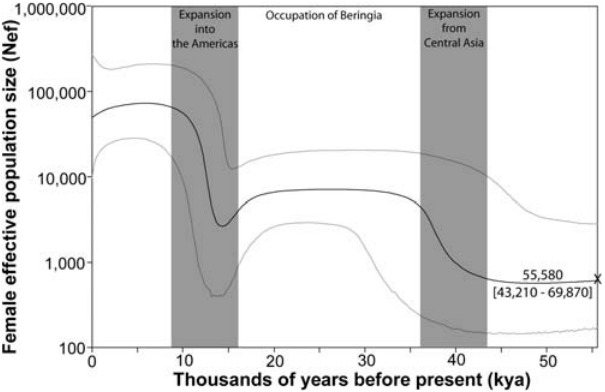
Figure 1. Bayesian skyline plot for the mtDNA coding genome sequences. The curve plots median N ef with its 95% CI indicated by the light gray lines. The calculated N ef assumes a generation time of 20 years following Hey [16]; alternatively, using a generation time of 25 years [55] would uniformly decrease all estimates of N ef by 20%. ‘‘ X ’’ marks the median coalescent time with its 95% CI given in brackets. The shaded regions highlight two periods of substantial population growth. This skyline plot provides the principal evidence for our three-stage model of New World colonization, i.e. the three stages that are depicted and labeled